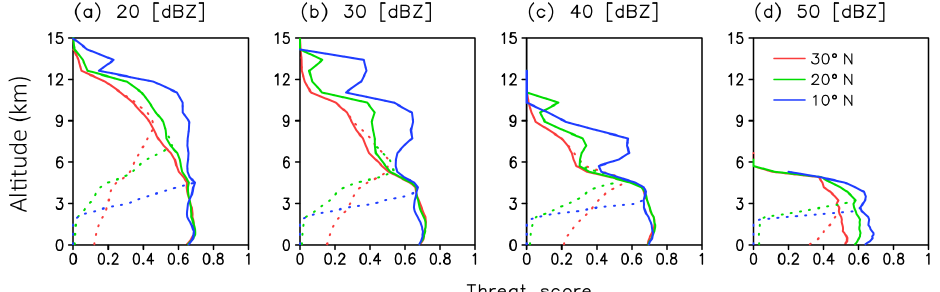
Figure 13. Threat score with a threshold of (a) 20, (b) 30, (c) 40, and (d) 50 (dBZ) for the typhoons whose centers are in 30 ◦ N (red), 20 ◦ N (green), and 10 ◦ N (blue). The dotted and solid lines show the threat score with and without considering the impact of surface clutter, respectively.